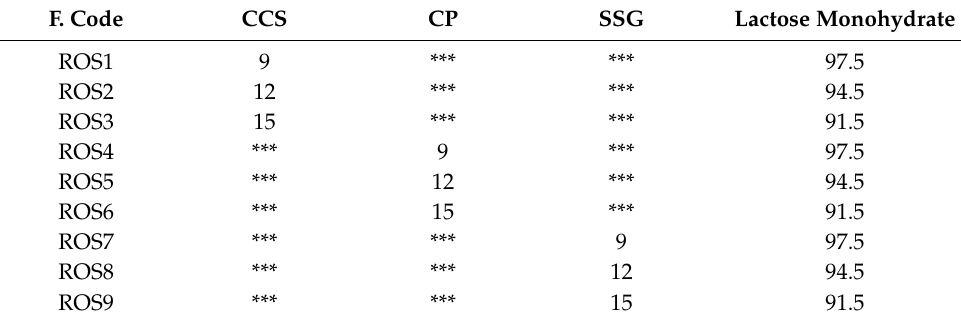
Table 1. Composition of different ROS-IRL mono